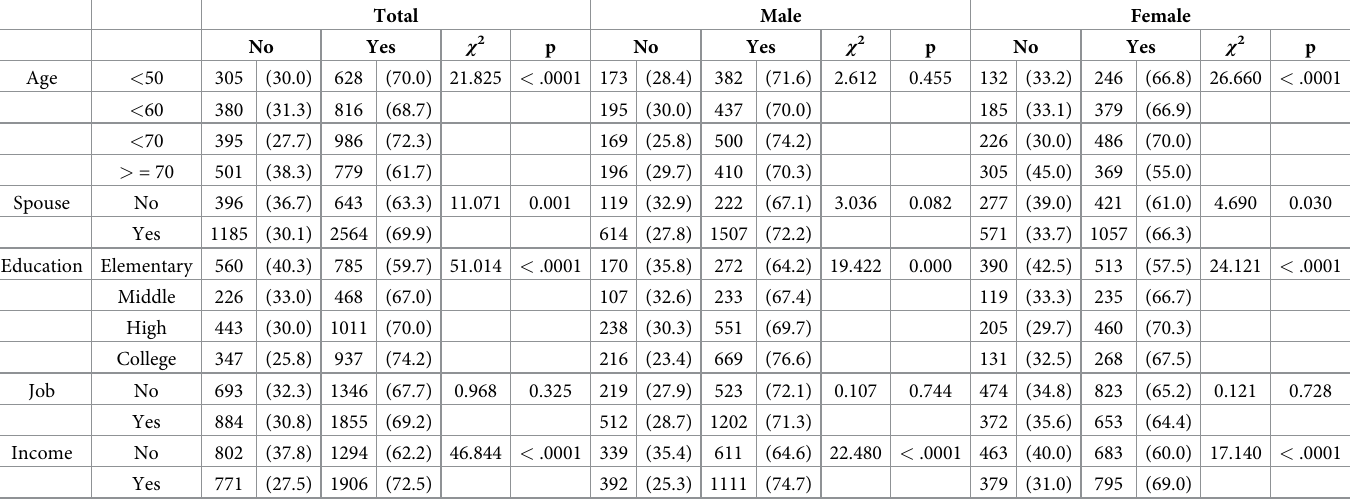
Table 2. Differences in regular workout habits based on general